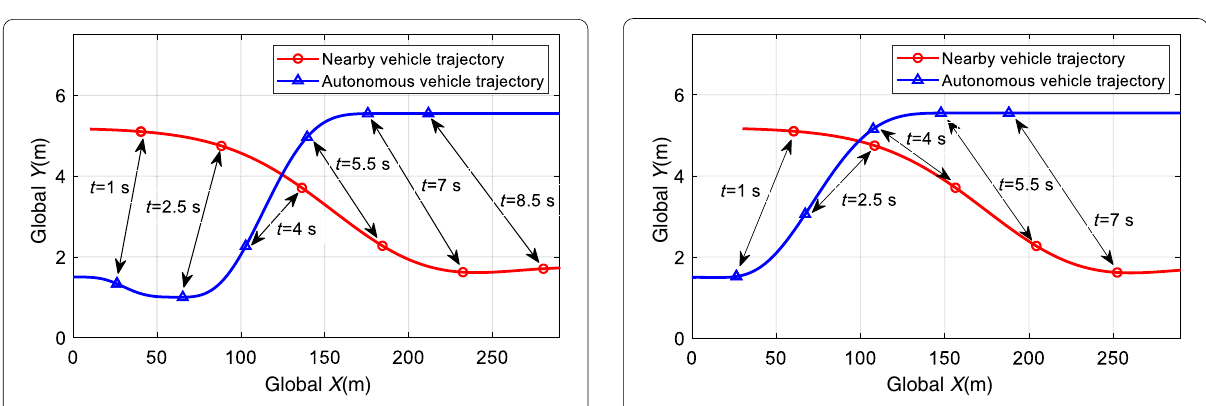
Figure 8 Vehicle trajectories in the lane-exchanging scenario when initial longitudinal distance is 10 m